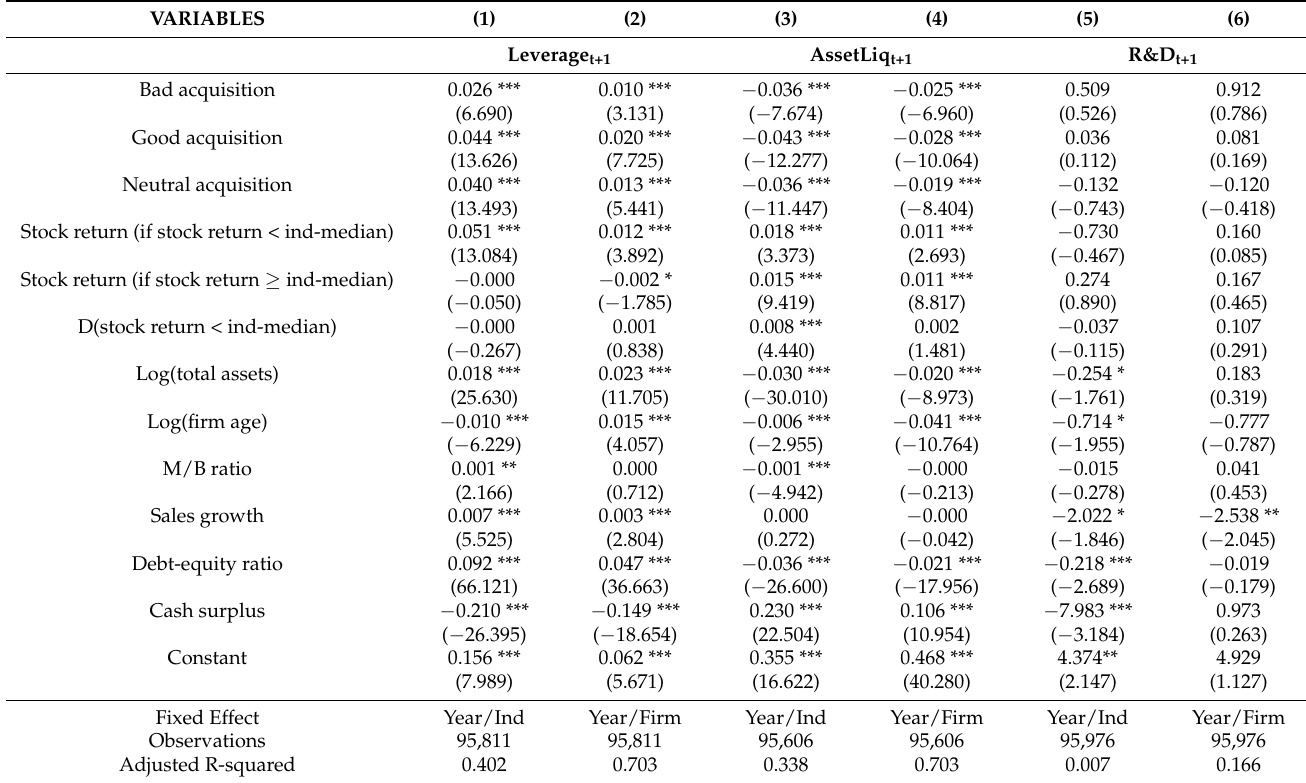
Table 7. Financial and investment risk. This table presents the OLS regression results for the sample of firm-year observations between 1990 and 2015. The dependent variable in Column (1) and (2) is financial leverage in fiscal year t+1. The dependent variable in Column (3) and (4) is the asset liquidity measure in fiscal year t+1. The dependent variable in Column (5) and (6) is R&D expense/sales in fiscal year t+1. Other variable definitions are in the Appendix A. All regressions control for fiscal-year fixed effects and firm fixed effects whose coefficients are suppressed for brevity. t-statistics based on standard errors adjusted for heteroskedasticity (White 1980) and firm clustering are reported in parentheses. *, **, and *** denote statistical significance at the 10%, 5%, and 1% levels,